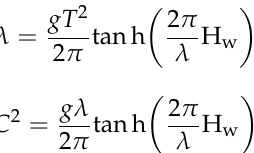
Figure 6. Photo after the preparation of model C.